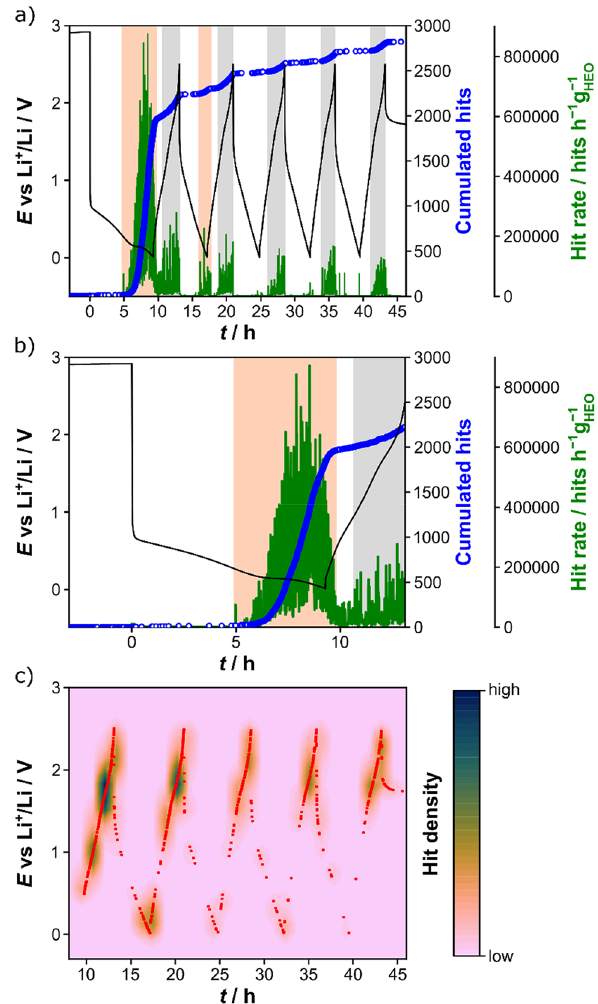
Figure 1. ( a ) Voltage profile for the first five cycles (black) and corresponding cumulated hits (blue) and hit rate (green). ( b ) Enlarged view of the first cycle. Orange and gray shaded areas indicate major acoustic activity during lithiation and delithiation, respectively. ( c ) Contour plot of acoustic activity (hit density) as a function of time and voltage (starting from the initial delithiation cycle at 0.5 V vs Li + /Li). Hits are denoted by red